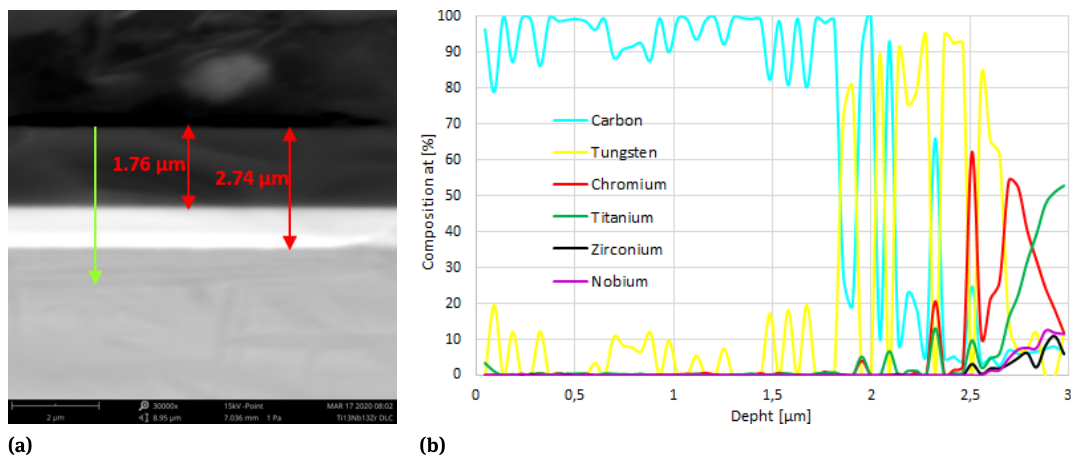
Figure 4: The thickness of DLC coatings (a), distribution of elements from the surface down into the a-C:H coating atomic percentage (b)